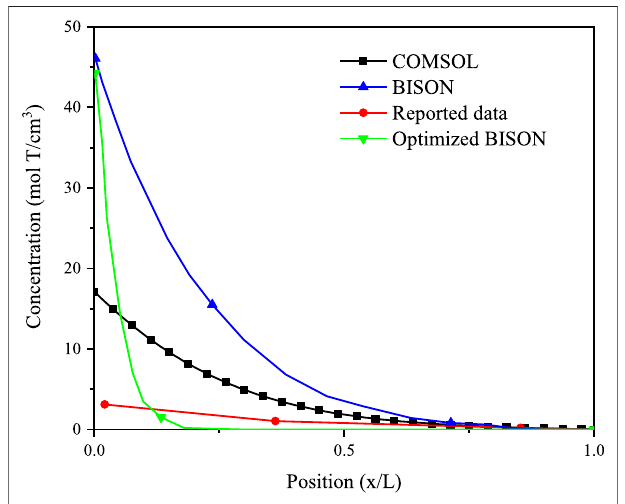
FIGURE 2 | Tritium distribution at the radial direction in the FeCrAl cladding of simulated and experimental results at 50,000 s, and concentrations are times 10 12 .